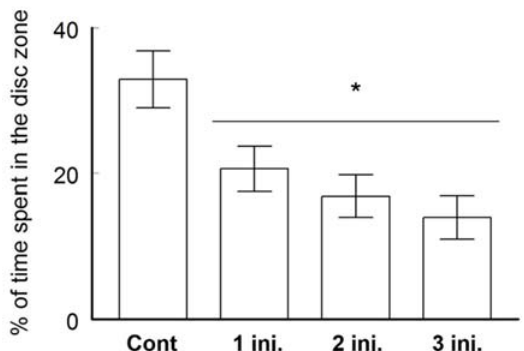
Figure 3. Spatial learning and memory assessed on BALB/C mice using a MWM. Percentage of time spent in the platform (disc) zone by each group of animals. Data are expressed as mean ± SEM ( n = 3); * p < 0.05 when compared to control.